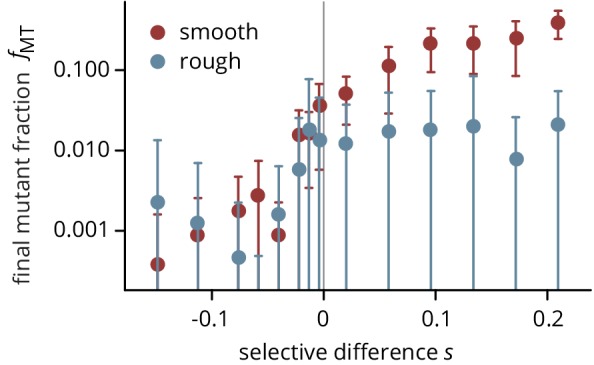
Final frequency of mutants after 3 days of growth, on smooth (red) and rough (blue) plates.Same data as Figure 2a, plotted on a semi-logarithmic scale.